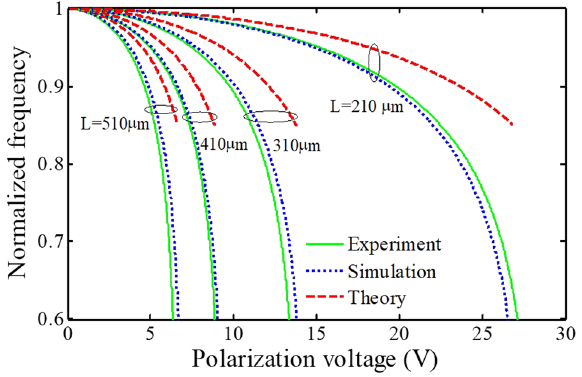
Figure 5. Frequency validation with available experimental and theoretical results 58 : normalized frequency vs. polarization voltage of manipulators with different electrode length.